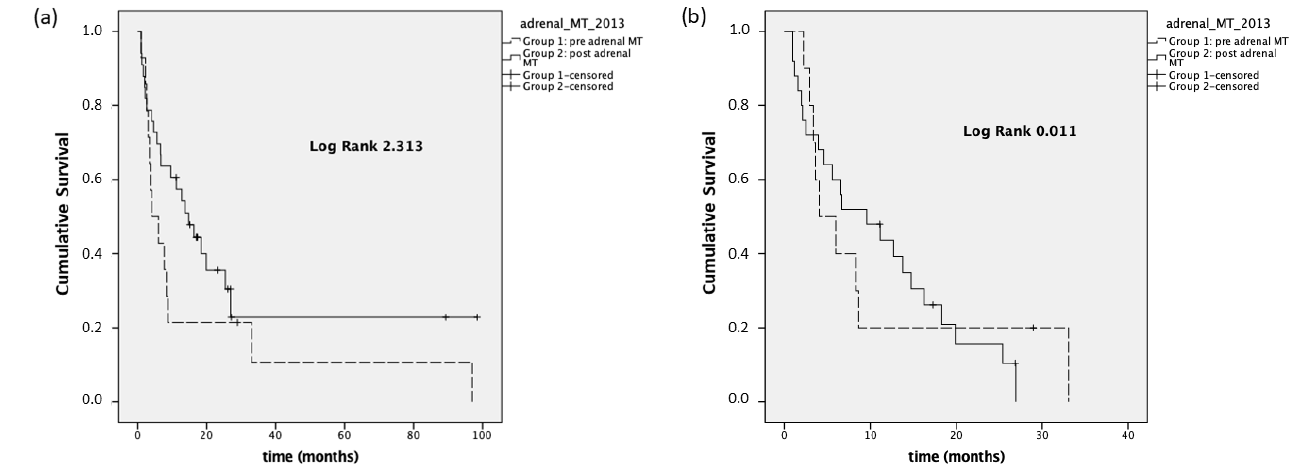
Figure 4. Panel ( a ): PFS first visit , stage I–IV; panel ( b ): PFS first visit , stage Figure 4. panel ( a ): PFS first visit , stage I–IV; panel ( b ): PFS first visit , stage III–IV.